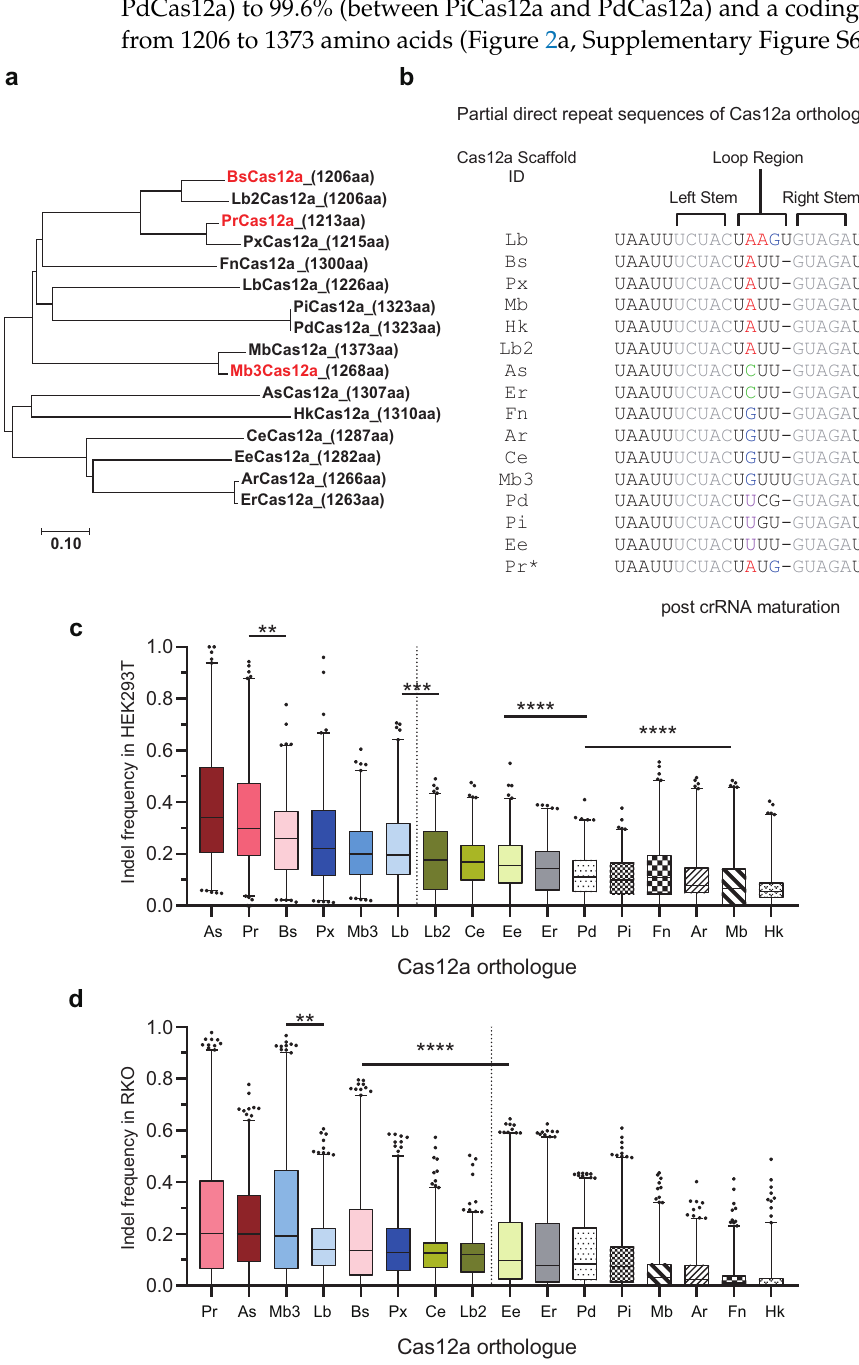
Figure 2. High-throughput evaluation of the editing activity of 16 Cas12a orthologues on target sites with canonical TTTV PAMs in HEK293T and RKO cells. ( a ) Phylogenetic tree of 16 Cas12a orthologues generated by MEGA7.0.26 (see Supplementary Figure S6). ( b ) Alignment of direct repeats (DRs) from the 16 Cas12a orthologues. The conserved stem duplex is highlighted in gray, and the non-conserved bases in the loop region are colored. ( c , d ) Editing activity evaluation among 10 Cas12a orthologues at target sites with TTTV PAMs in HEK293T (c, n = 500) and RKO (d, n = 1000) cells. V = A/C/G. Box-whisker plots: median line, quartiles for box edges, 1–99% whiskers. ** p < 0.01, *** p < 0.001, **** p < 0.0001. For details of sample size and of the statistical analyses, see the Supplementary